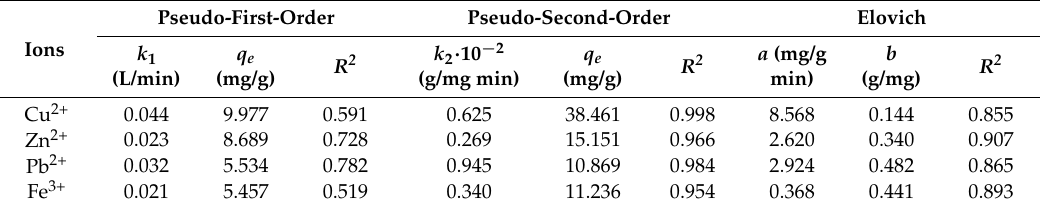
Table 1. Kinetic parameters of the pseudo-first-order and the pseudo-second-order and Elovich rate equations for ions metals adsorption on IIP/Mt nanocomposites.